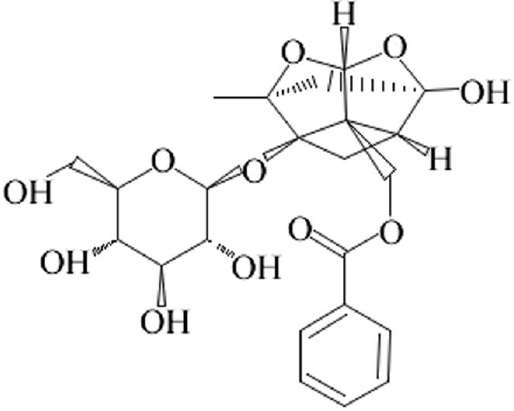
Figure 1. The chemical structure of paeoniflorin.